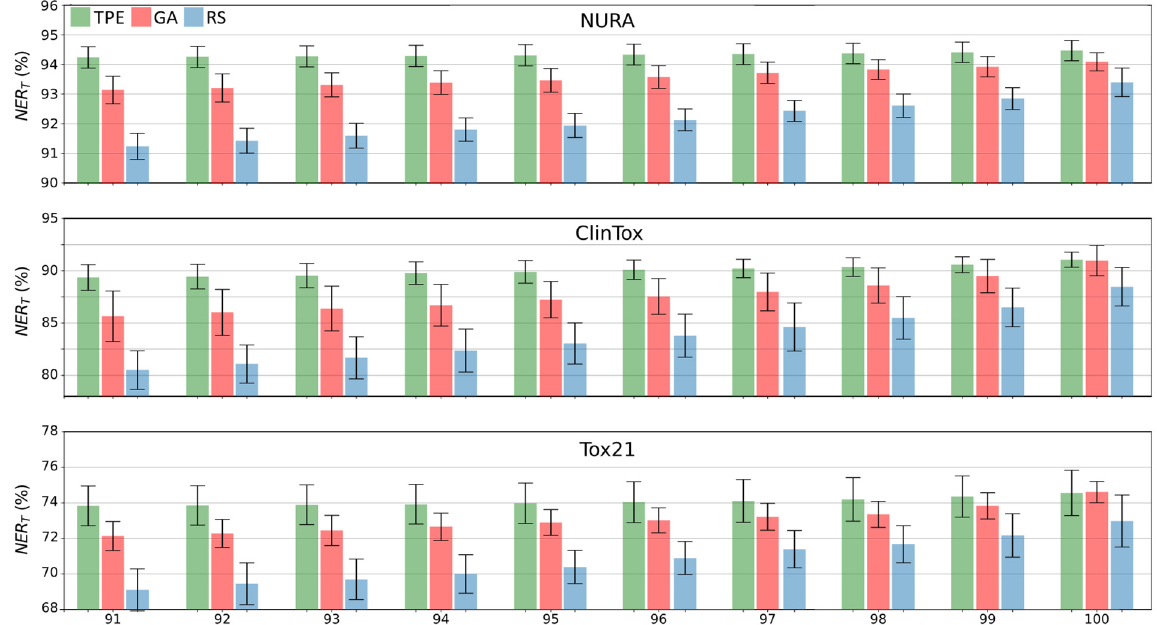
Figure 2. Overall non-error rate (NER T ) of the best 10 solutions for each dataset and optimization method (tree-structured Parzen estimator, TPE, genetic algorithms, GA, and random search, RS, in green, red, and blue, respectively). Error bars are calculated considering the variability over 10 replicas.